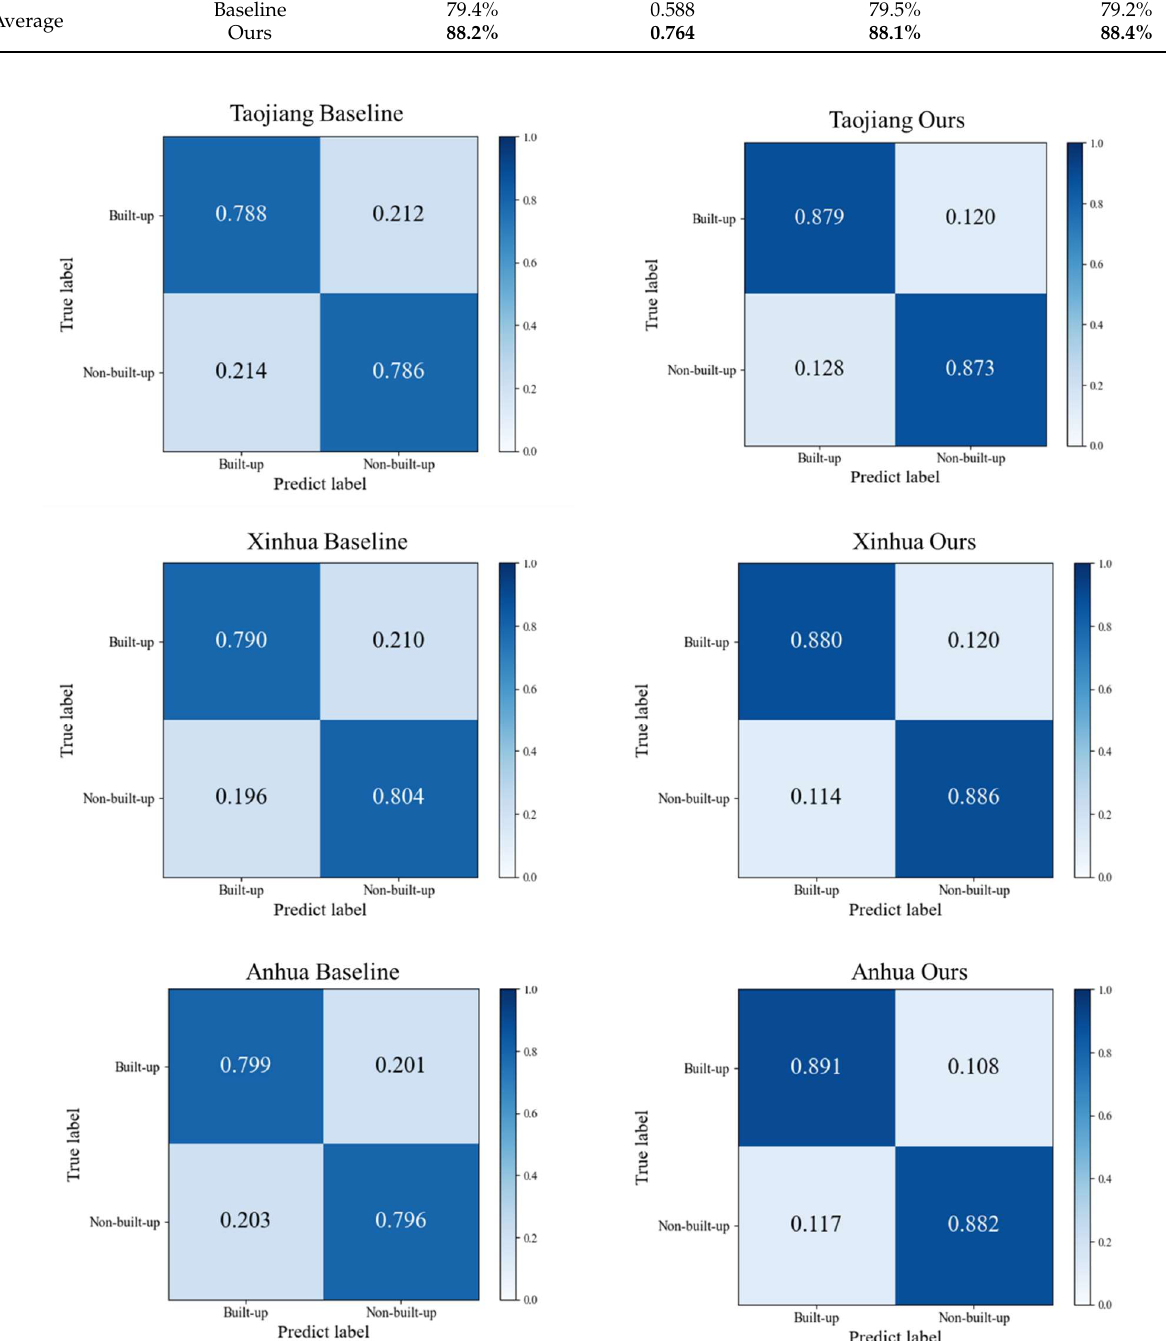
Figure 8. Confusion matrices results. First row: Taojiang results; second row: Xinhua results; third row: Anhua results. First column: baseline results; second column: our method’s results.